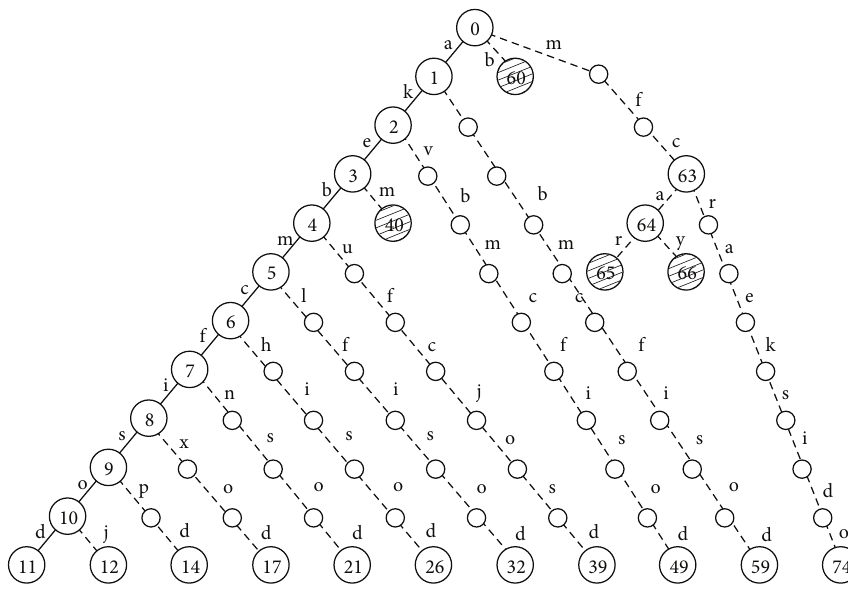
Figure 2: Search tree when the basic cell selector and no EAD are